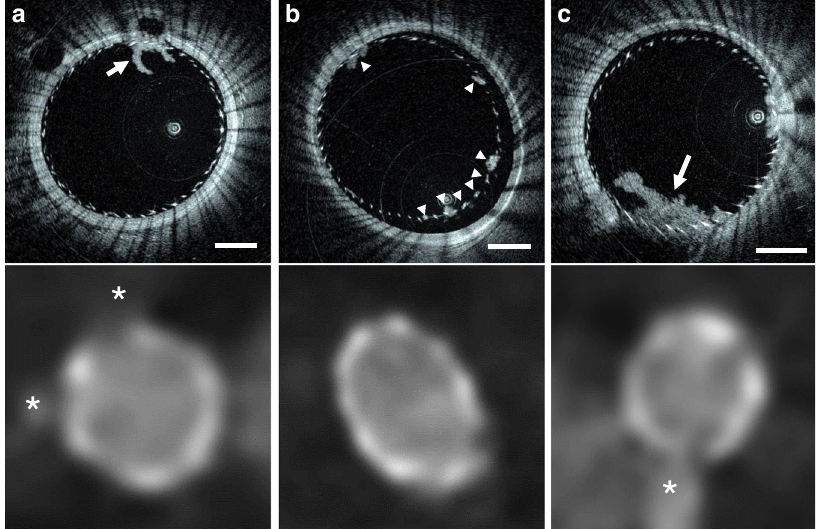
Fig. 5 Cross-sectional HF-OCT images compared to corresponding CBCT slices. a A side-branch thrombosis is visible on the HF-OCT image (arrow). b Flow-diverter malapposition with a maximum severity of ~400 µ m is visible on the HF-OCT image between 1 and 8 o ’ clock. Small thrombus formations over the fl ow-diverter struts, with a thickness between ~30 and 220 µ m, are indicated by the arrowheads. The presence of thrombus and device malapposition are often undetected on the corresponding cone beam CT images. c Thrombosis on the ostium of a large side-branch. HF-OCT comparison with CBCT was repeated for all swine internal maxillary arteries ( n = 16), following fl ow-diverting ( n = 16), and self-expanding intracranial stent implantation ( n = 15). Scale bars on HF-OCT images are equal to 1 mm. The star symbol (*) on CT images denotes the location of